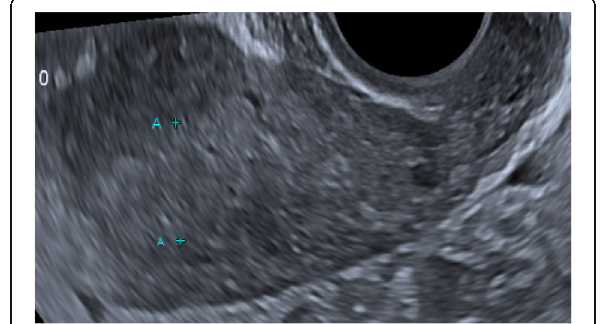
Fig. 7 Sagittal view by TVUS showing a thickened endometrium measuring about 30 mm in maximal anteroposterior diameter, heterogenous echo pattern, and multiple hypoechoic areas with indistinct borders. Histopathology result of the endometrial biopsy was consistent with endometrial